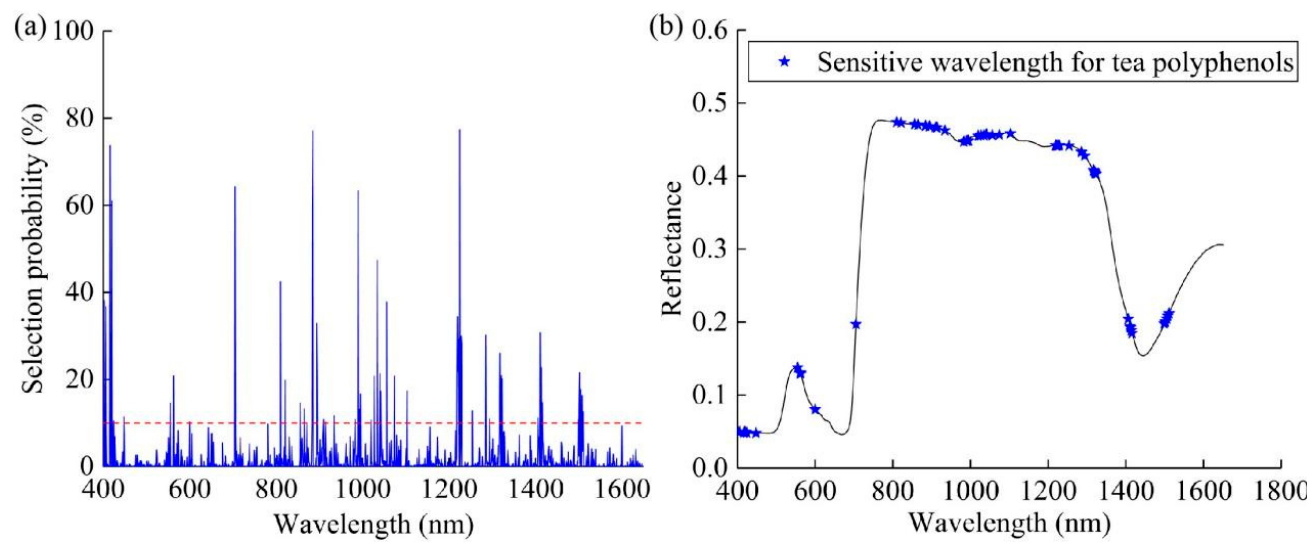
Figure 8. Sensitive wavebands related to tea polyphenol content extracted by RF algorithm. ( a ) Selection probability of different wavelengths, and ( b ) distribution of the first 62 selected sensitive wavebands.